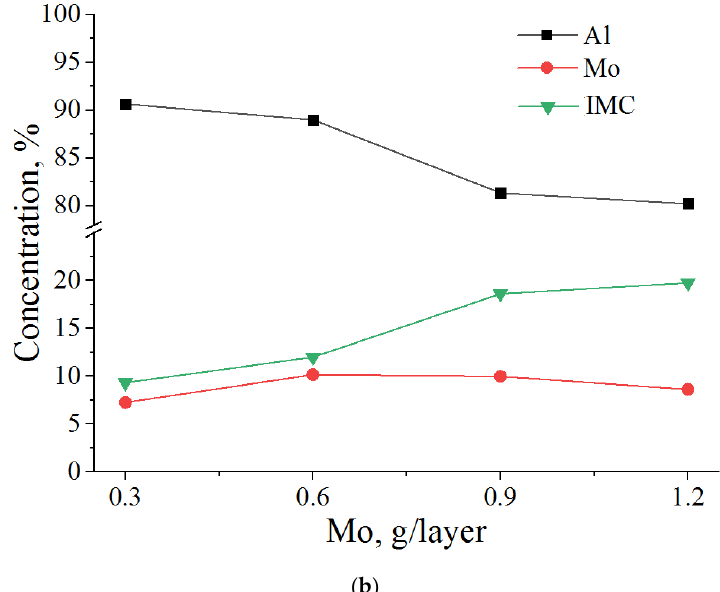
Figure 5. XRD diffractograms ( a ) and volume fractions of structural components ( b ) as depending on the Mo powder bed input.